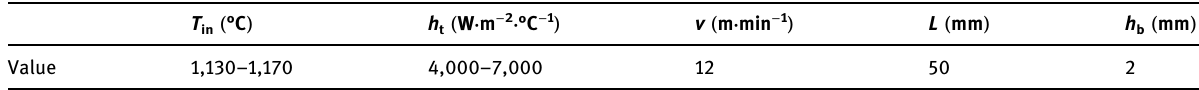
Table 2: Process parameters of casting strip